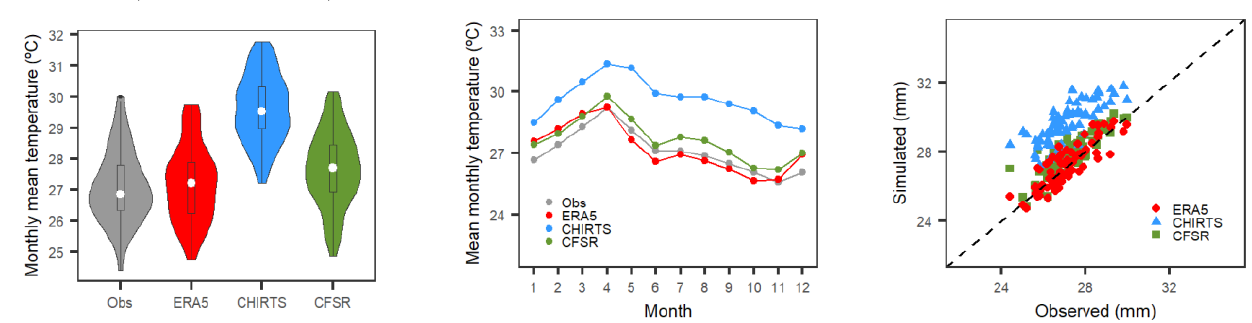
Figure 5. Comparison of average monthly observed temperature with ERA5, CHIRTS, and CFSR datasets using violin plots ( left column), variations in rainfall patterns ( central column) and scatterplots ( right column).